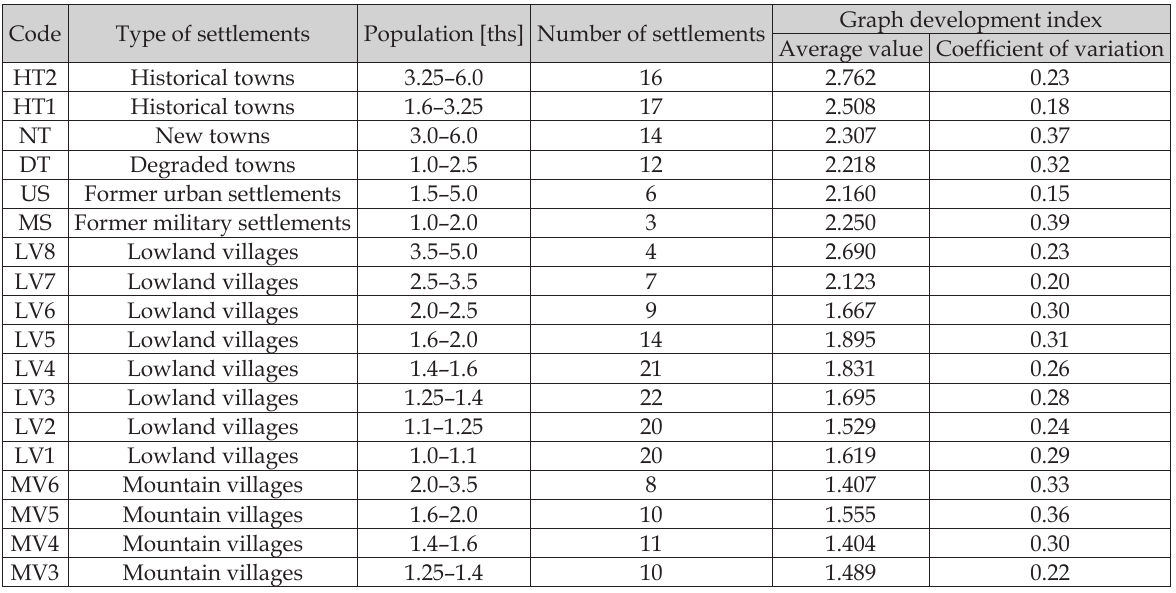
Table 4. Graph development index (G